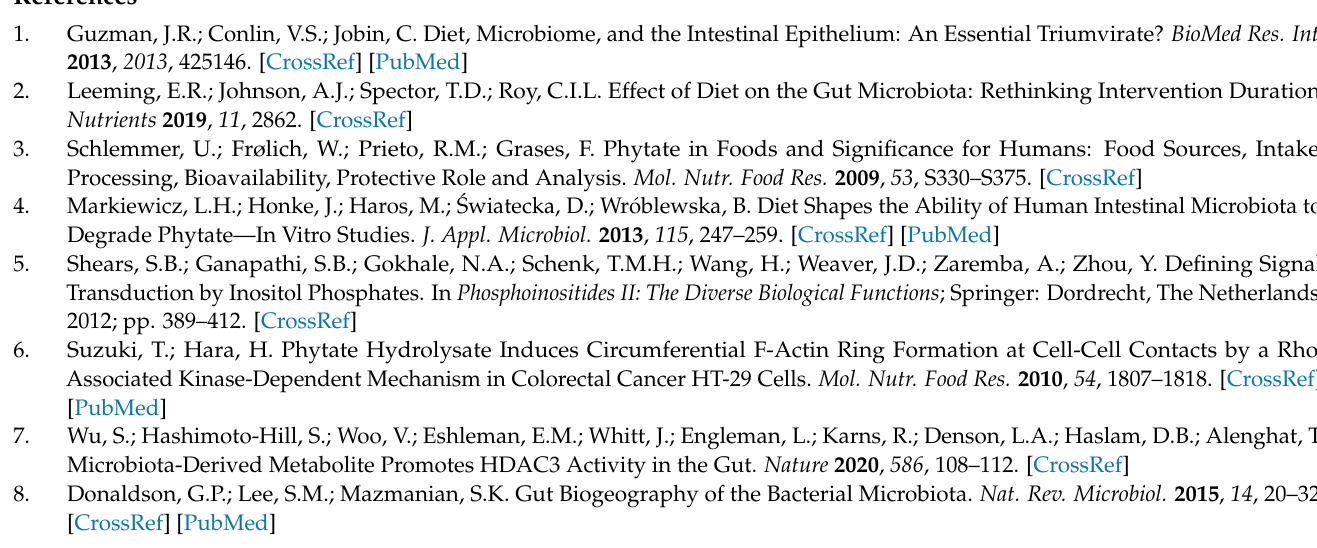
immunoblots representing detection of indicated proteins in the whole cell extract from NCM460D cells. Figure S3: Secretion of IL-6 and IL-12p70 by healthy and cancer colonocytes (NCM460D and HCT116 cell lines, respectively) after incubation for 2 h with cultures of fecal bacteria alone (BM) or with bacterial cultures and phytate hydrolysate (BM + hPA120). V and O—fecal bacteria obtained from vegan and omnivorous volunteers, respectively. Cultures of fecal bacteria were carried out in modified Wilkins–Chalgren medium supplemented with 1 mM phytic acid and 0.5% mucin, incubated in anaerobic atmosphere, at 37 ◦ C for 40 h. Whiskers—non-outliers, box—25–75% non-outliers; horizontal line in the box—median; empty circles—outliers, Figure S4: Exemplary immunoblots representing detection of indicated proteins in the whole cell extract from HCT116 cells, Figure S5: Concentrations of cytokines released to culture medium by NCM460D cells after 2 h of incubation with BM (human gut bacteria grown in the presence of mucin and phytic acid) or BM and hydrolysate of phytic acid (BM + hPA120), Figure S6: Concentrations of cytokines released to culture medium by HCT116 cells after 2 h incubation with BM (human gut bacteria grown in the presence of mucin and phytic acid) or BM and hydrolysate of phytic acid (BM + hPA120), Table S1: List of the authentic standards used for HPLC-MS analysis of the phytate preparation, Table S2: Primers applied in the